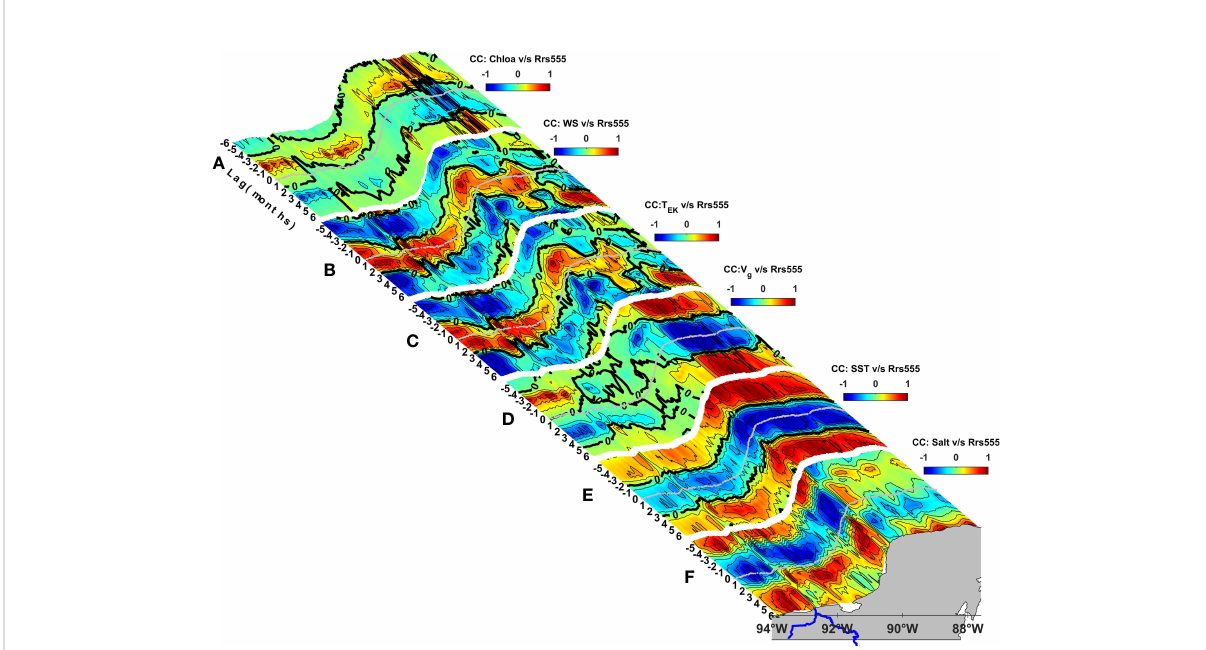
FIGURE 7 Hovmöller Diagram of the Cross-Correlation Coef fi cient (CC) between: (A) Chlorophyll and Turbidity (Rrs555), (B) Wind Effort and Turbidity (Rrs555), (C) Southern Ekman Transport and Turbidity (Rrs555 ), (D) Geostrophic Velocity and Turbidity (Rrs555), (E) Sea Surface Temperature and Turbidity (Rrs555) and (F) Modeled Salinity and Turbidity